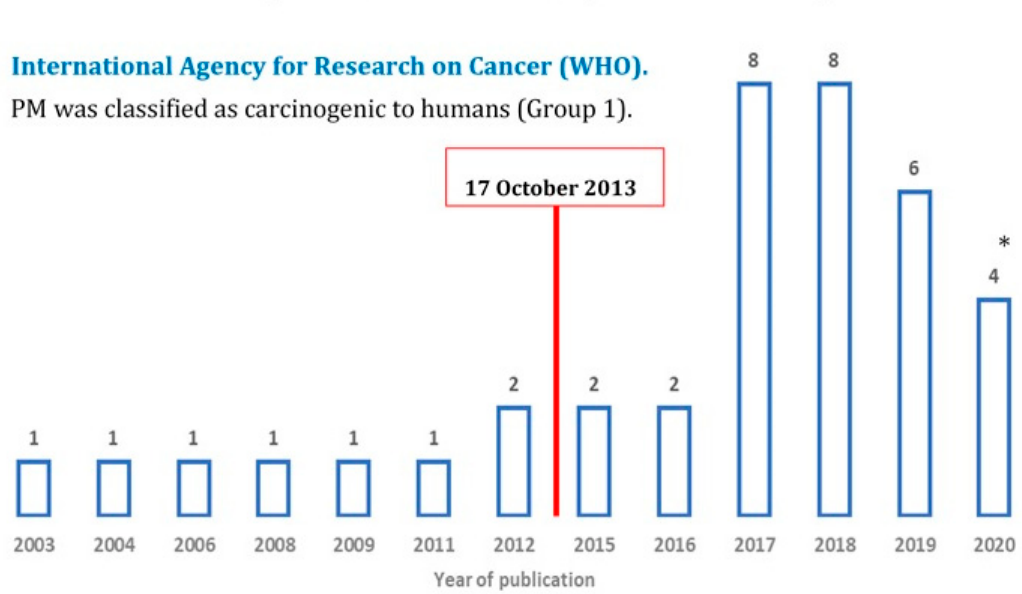
Figure 3. Timeline distribution of the articles included in the systematic review. * Only January, February, and March were included for the year 2020.